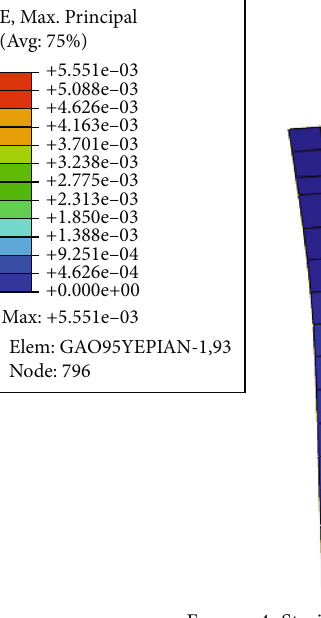
Figure 4: Strain cloud diagram of blade (maximum-continuous working state). Table 2: Stress and strain results of three working